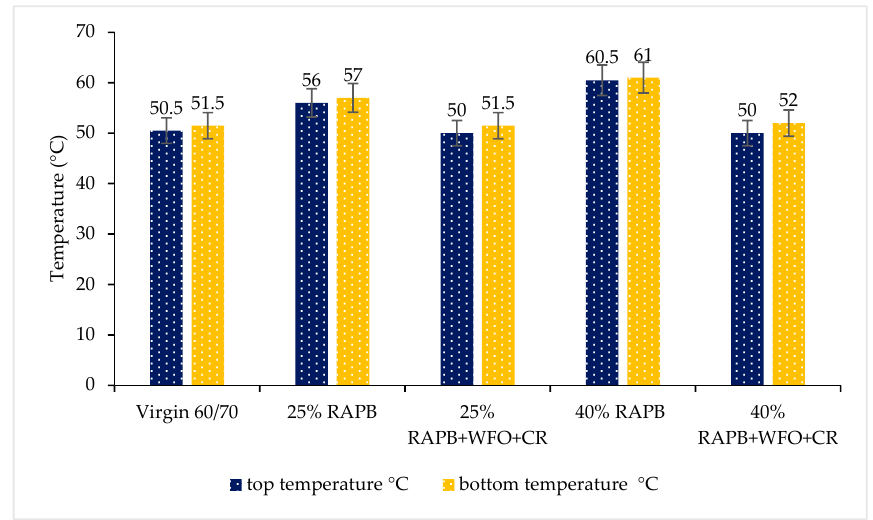
Figure 5. Storage stability results are based on the difference between the softening point values of top and bottom temperature.